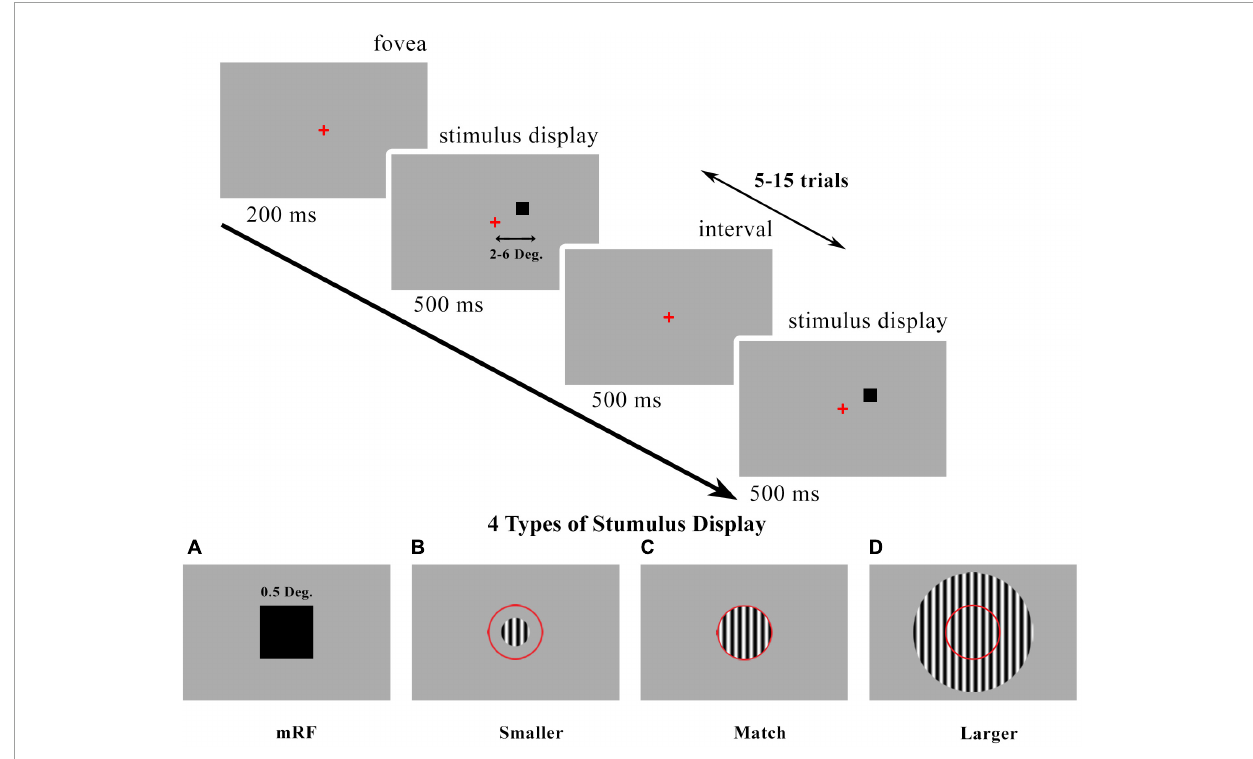
FIGURE1 Visual presentation timeline. Local field potentials (LFPs) were recorded in V1 cortical column (2 ◦ − 6 ◦ eccentricities). The desired stimulus is presented at 500 milliseconds, 5–15 trials, and interleaved with 500 milliseconds. (A) 0.5 ◦ black square stimulus centered on the columnar minimum receptive field (mRF). Drifting grating patch stimulus with changes in size [smaller than receptive field (RF) (B) match stimulus size with RF (C) and larger than RF (D) ]. The red circle is a schematic view of the RF. We called these drifting grating types of stimuli as summation RF (SRF). Red present the center of fovea.